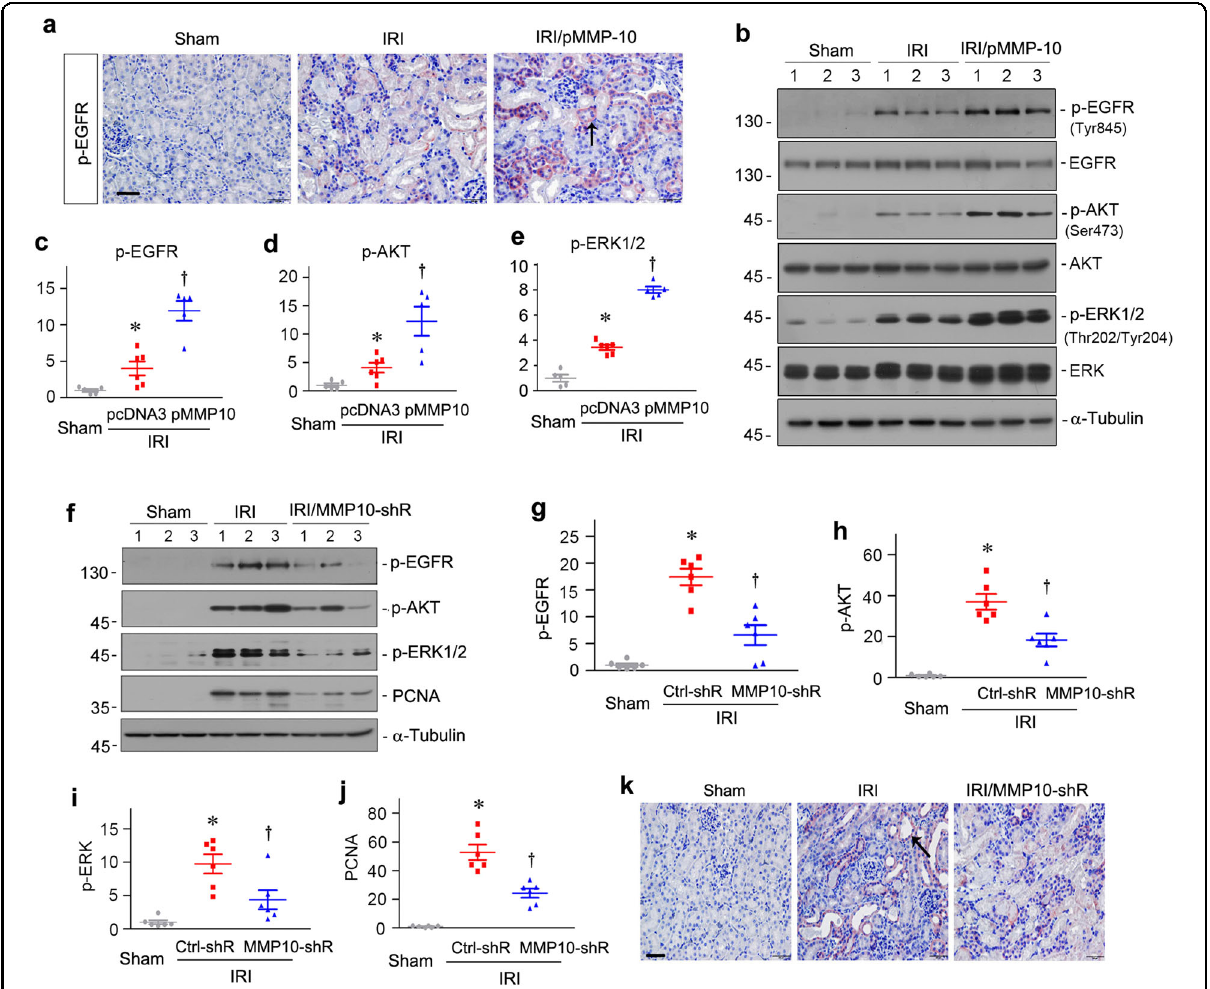
Fig. 5 MMP-10 activates epidermal growth factor receptor (EGFR) signaling. a Micrographs show that exogenous MMP-10 promoted renal expression of phosphorylated EGFR after IRI. Representative image from fi ve animals ( n = 5). Arrow indicates positive staining of phosphorylated EGFR (Tyr845). Scale bar, 50µm. b Representative western blots show renal expression of p-EGFR (Tyr845), total EGFR, p-AKT (Ser473), total AKT, p-ERK1/2 (Thr202/ Tyr204), and total ERK1/2 in different groups as indicated. Numbers (1, 2, and 3) indicate each individual animal in a given group. c – e Graphic presentations show the quantitative data of p-EGFR ( c ), p-AKT ( d ) and p-ERK1/2 ( e ) in different groups as indicated. * P <0.05 versus sham controls ( n = 5 – 6); † P <0.05 versus IRI injected with pcDNA3 ( n = 5 – 6). f Knockdown of MMP-10 inhibited EGFR signaling after IRI. Representative western blots show renal expression of p-EGFR, p-AKT, p-ERK1/2, and PCNA in different groups as indicated. Numbers (1, 2, and 3) indicate each individual animal in a given group. g – j Graphic presentations show the quantitative data of p-EGFR (Tyr845) ( g ), p-AKT (Ser473) ( h ), p-ERK1/2 (Thr202/Tyr204) ( i ), and PCNA ( j ) in different groups as indicated. * P <0.05 versus sham controls ( n = 6); † P <0.05 versus IRI injected with Ctrl-shR ( n = 6). k Representative micrographs show renal expression of p-EGFR in different groups as indicated ( n = 6). Arrow indicates positive staining. Scale bar,